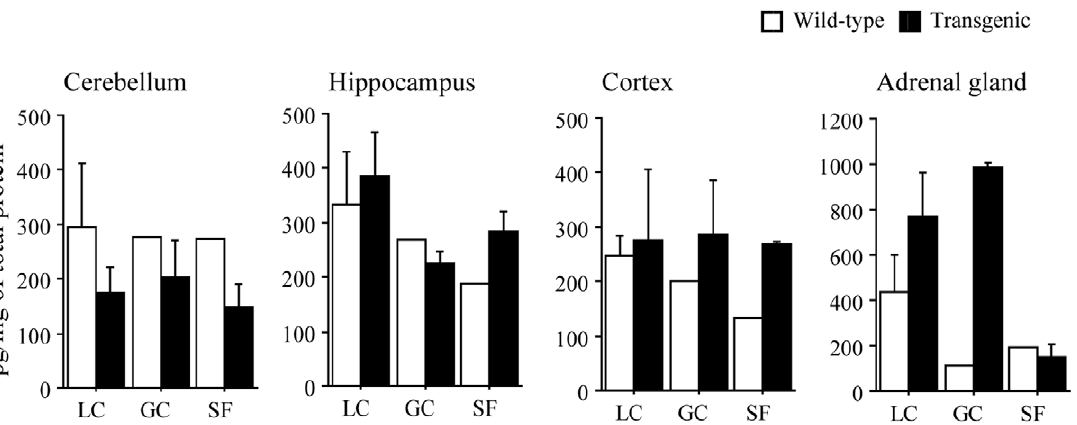
Figure 1. Responses of nerve growth factor in brain and adrenal gland. LC, GC, and SF: laboratory control, ground control, and spaceflight group, respectively. The numbers of wild type mice in LC, GC, and SF are 3, 1, and 1. Those of transgenic mice are 3, 2, and 2. Mean 6 SEM.